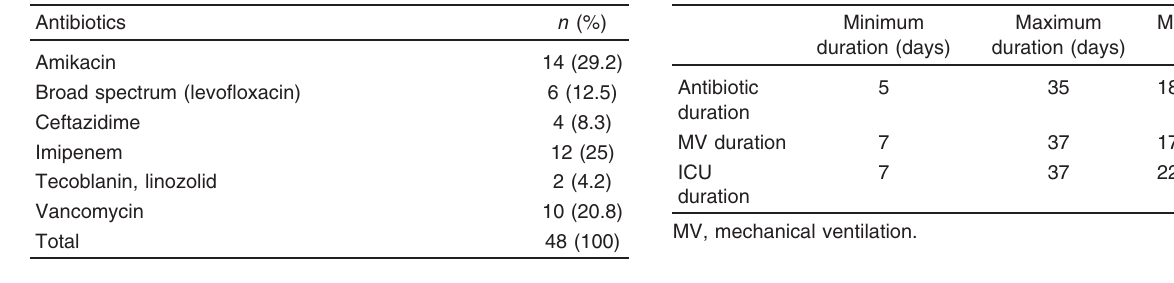
Table 11 Types of antibiotics used to treat ventilator- associated pneumonia (according to culture and sensitivity test)